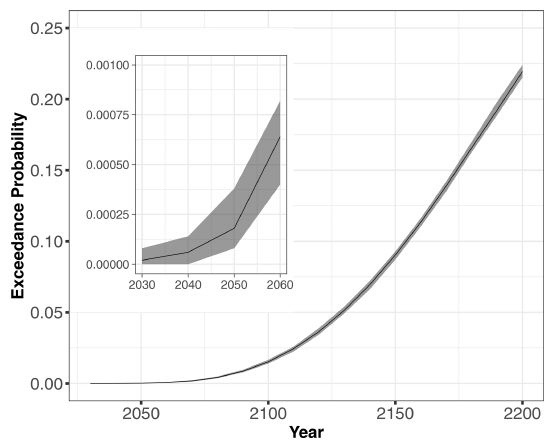
Figure 7. Time evolution of the probability of the event { m Y > Y C = 2000m 3 } given SLR projections for the scenario RCP4.5. The inserted figure indicates the very small uncertainty band’s width, whose limits are the lower and upper bounds computed using B = 50 replicates of the estimation procedure (Sect. 3.5) accounting for GP and sampling